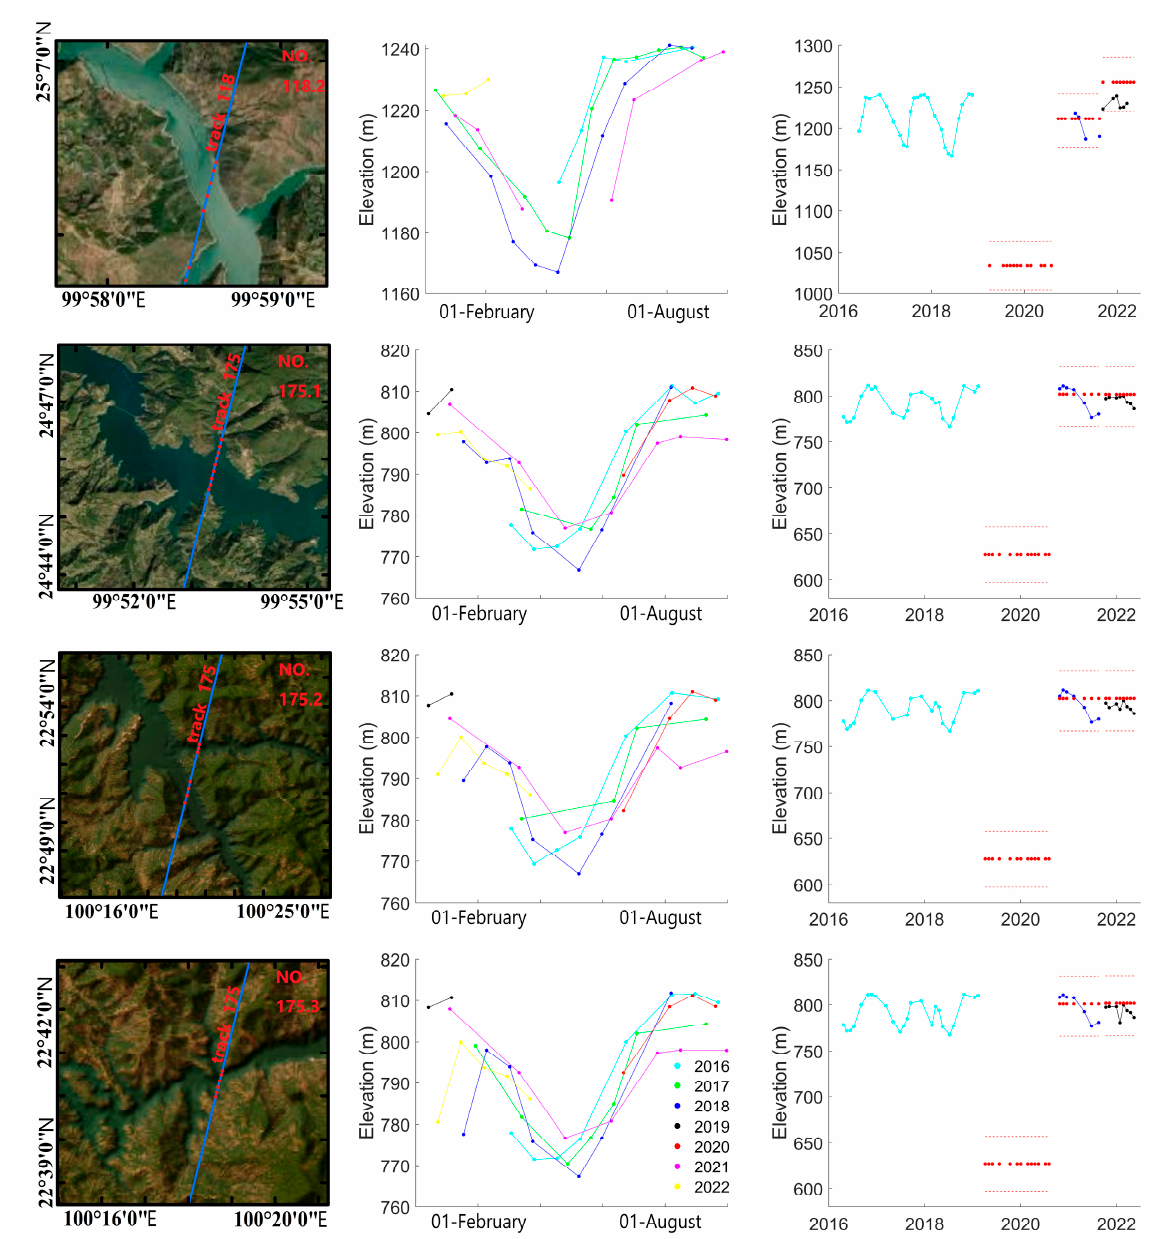
Figure 9. Four VSs in the reservoir areas. The satellite image shows the locations of the VSs, with the orbit of Sentinel ‐ 3A (S3A) indicated by the blue line. The orbit numbers are shown in red next to the orbit, and the red dots on the orbit indicate the location of the satellite emitting detection waves at the corresponding VSs. The VSs number is displayed in red font in the upper right corner of the image. The figure in the middle is the variation of WSE variation at the same time for different years. Figure in the right is show the time series of the WSE for the specific VS, where azure, green, blue, and black refer to closed ‐ loop, OLTC V5.0, OLTC V6.0, and OLTC V6.1.